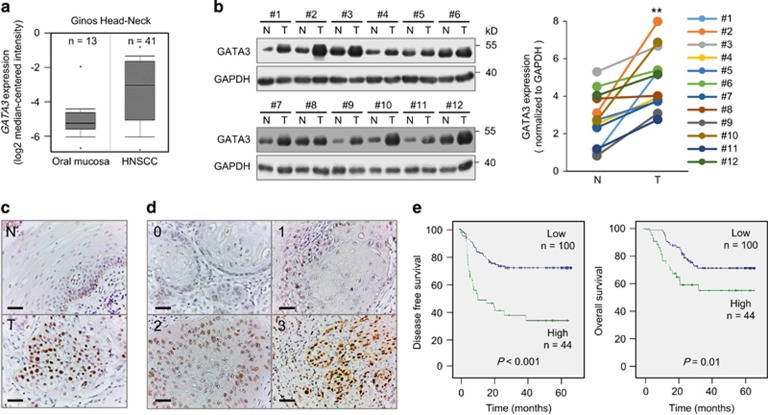
GATA3 is overexpressed in HNSCC and high GATA3 expression is associated with poor survivals. (a) GATA3 mRNA is overexpressed in HNSCC. GATA3 mRNA levels are higher in HNSCC (n=41) compared with normal oral mucosa (n=13). The data are retrieved from Ginos Head-Neck in the Oncomine database (https://www.oncomine.org). (b) Western blot analysis of GATA3 expression in paired HNSCC tumours (T) and adjacent non-tumour mucosa tissues (N) from 12 patients. Left: Western blots showing GATA3 expression and GAPDH control. Right: GATA3 expression was quantified and analysed by paired Student’s t-test. **P<0.01. (c) Representative images of immunohistochemistry of GATA3 in paired adjacent non-tumour mucosa (N) and tumour tissues (T) from HNSCC patients (n=15). Scale bars, 50 μm. (d) Scoring of immunohistochemistry of GATA3 in HNSCC tumour tissues. The intensity of GATA3 staining is scored from 0 to 3 and grouped into low (score=0, 1) and high (score=2, 3) expression. (e) Kaplan–Meier survival analysis. Patients with follow-up period over 18 months are included (n=144). Left and right panels indicate disease-free and overall survivals of patients with low and high GATA3 expression, respectively.